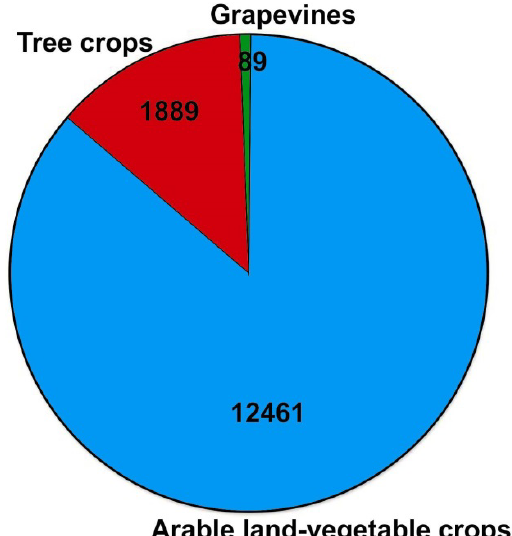
Figure 4. Irrigated land (in stremmas, 1 ha = 10 stremmas) in the upper part of the Gallikos River